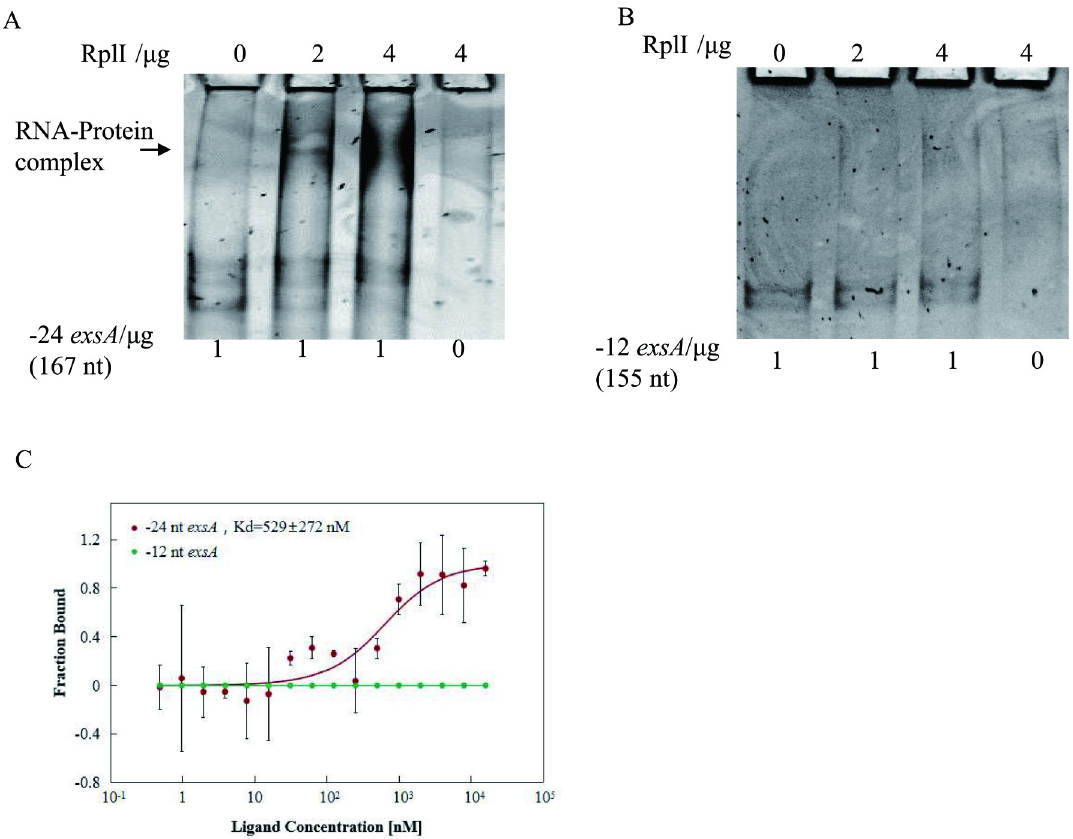
Fig 7. RplI interacts with exsA mRNA containing a 24 nt 5’ UTR but not a 12 nt 5’ UTR. (A and B) Binding of RplI to the indicated RNAs was examined by EMSA. Increasing amounts of purified P . aeruginosa RplI-His were incubated with 167 nt/155 nt (A/B) exsA mRNA respective corresponding to the 24 nt/12 nt 5’ UTR and its first 143 nt mRNA on ice for 30 min. The mixtures were electrophoresed on an 8% native polyacrylamide gel, and the bands were visualized by staining with Gel-red for 10 min. (C) MST assay to test the binding capability of purified P . aeruginosa RplI-His to the indicated RNA (same as A, B) transcribed in vitro. The error bar represents the standard deviation from triplicate assays for each sample.